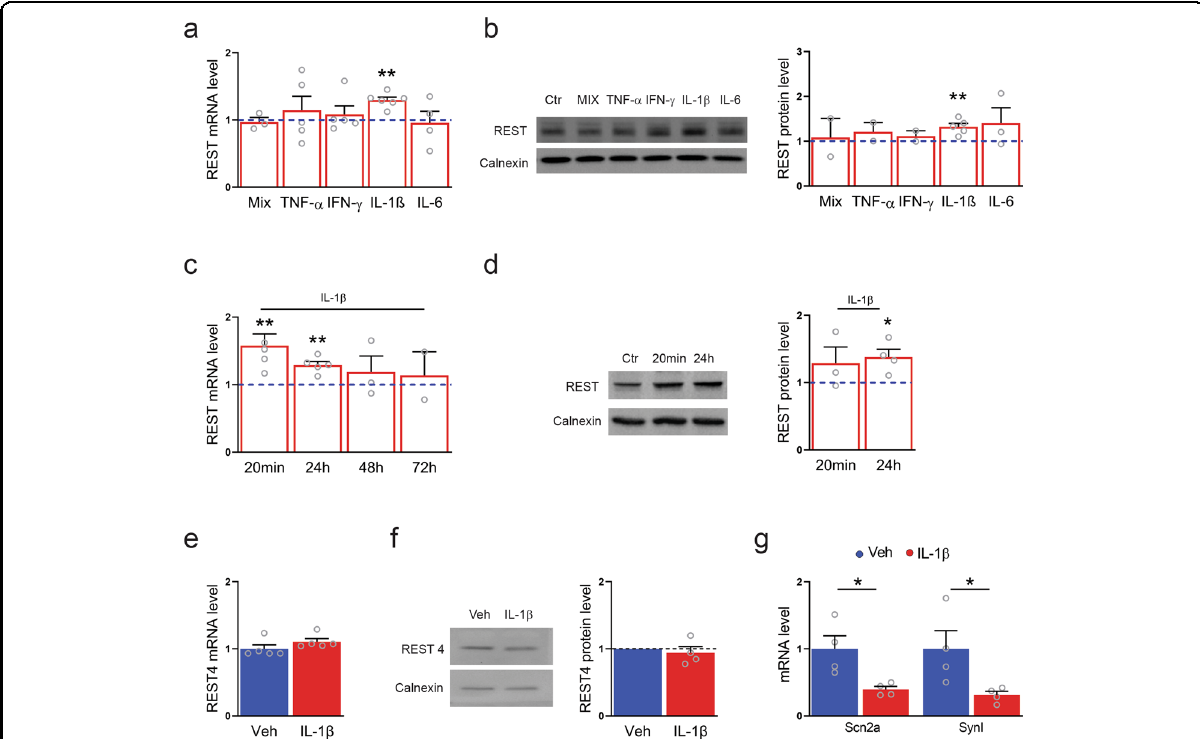
Fig. 3 Expression of REST is selectively regulated by IL-1 β in primary cortical neurons. a qRT-PCR analysis of REST mRNA levels upon treatment with the indicated pro-in fl ammatory cytokines for 24 h. b Representative immunoblot (left) and corresponding quanti fi cation (right) of REST protein levels under the same experimental conditions. c qRT-PCR analysis of REST mRNA levels upon IL-1 β treatment for various times, as indicated. d Representative immunoblot (left) and corresponding quanti fi cation (right) of REST protein levels upon treatment with IL-1 β for 20 min and 24 h, as compared to control condition. e , f qRT-PCR analysis ( e ) and immunoblotting ( f ) of REST4 upon exposure to either IL-1 β or vehicle (Veh) for 24 h. g The mRNA levels of the Na + channel Na V 1.2 (Scn2a) and synapsin I (SynI) were quanti fi ed by qRT-PCR in IL-1 β -treated neurons and compared to control. Gapdh, Actin, and Hprt1 were used as housekeeping genes in qRT-PCR analyses. Calnexin was used as loading control for western blotting analyses. Bar graphs show mean ± sem of at least n = 2 independent experiments with superimposed individual points. * p < 0.05, ** p < 0.01; one-way ANOVA/Bonferroni ’ s tests ( a – d ); unpaired two-tailed Student ’ s t test ( e – g